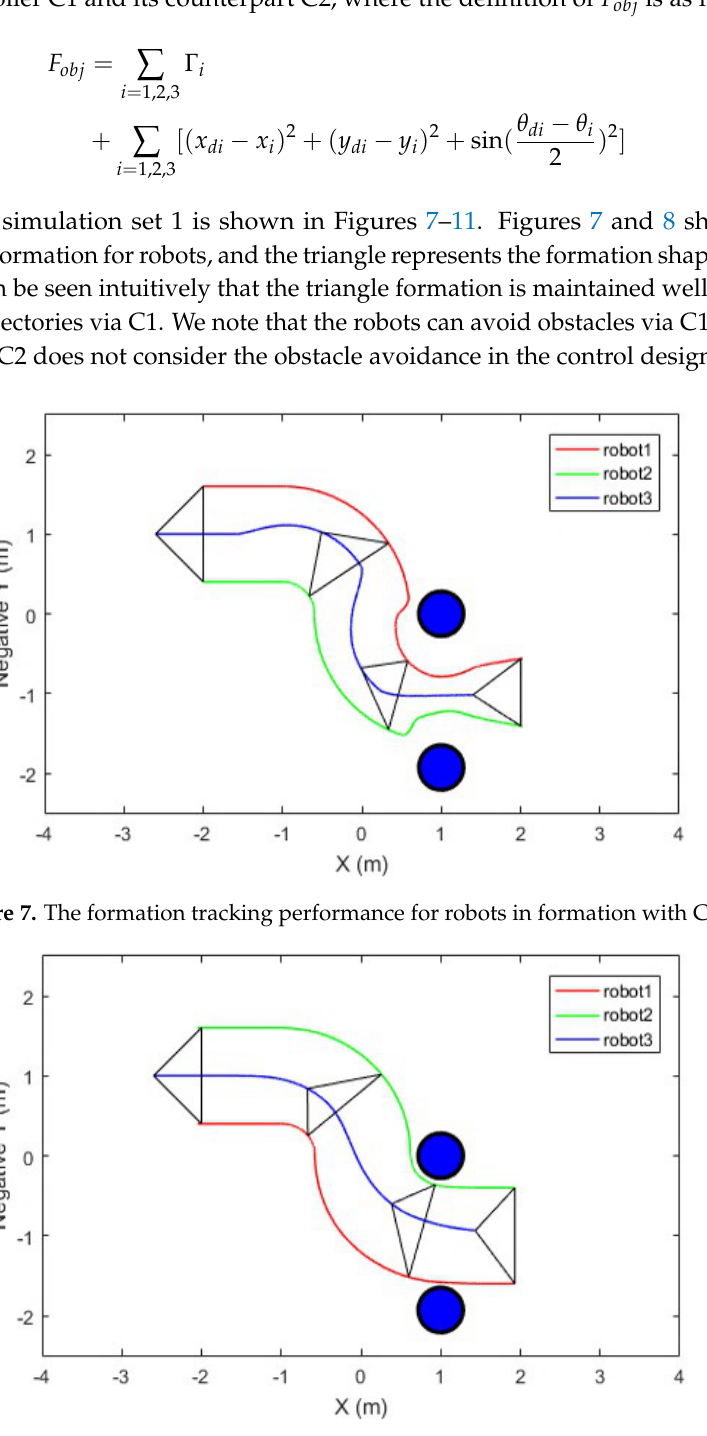
Figure 8. The formation tracking performance for robots in formation with